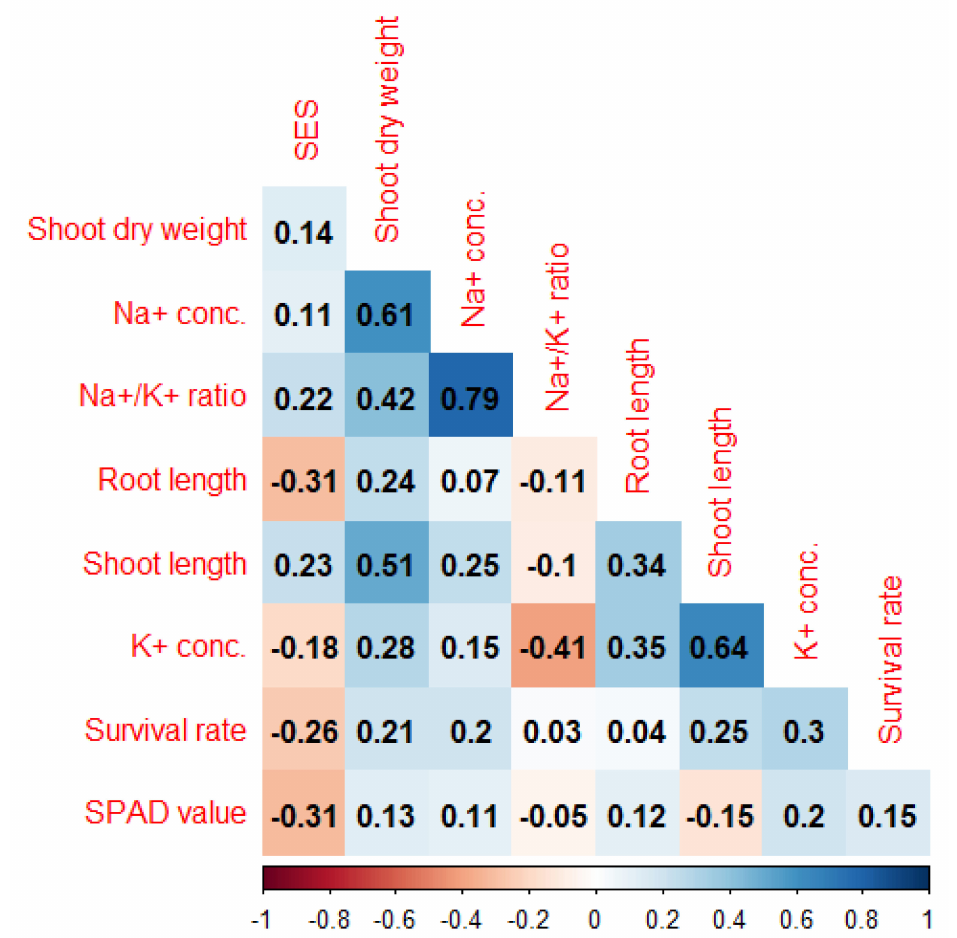
Figure 2. Correlation coefficients among different traits related to salt-tolerance in the F 2:3 population of a cross between BR49 (salt-sensitive) and Akundi (salt-tolerant) at seedling stage. Conc.: Concen- tration. Tabulated t -value at 5% level = 0.205, at 1% level = 0.267 indicate significance at p < 0.05 and p < 0.01,